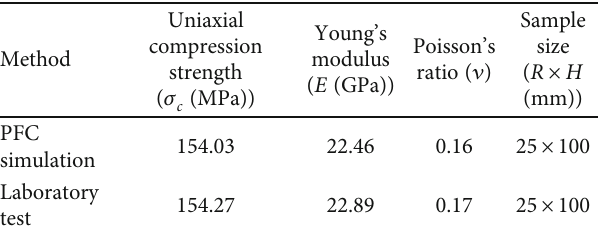
Table 2: Test and simulation results. Figure 1: Stress-strain curves obtained from the laboratory test and